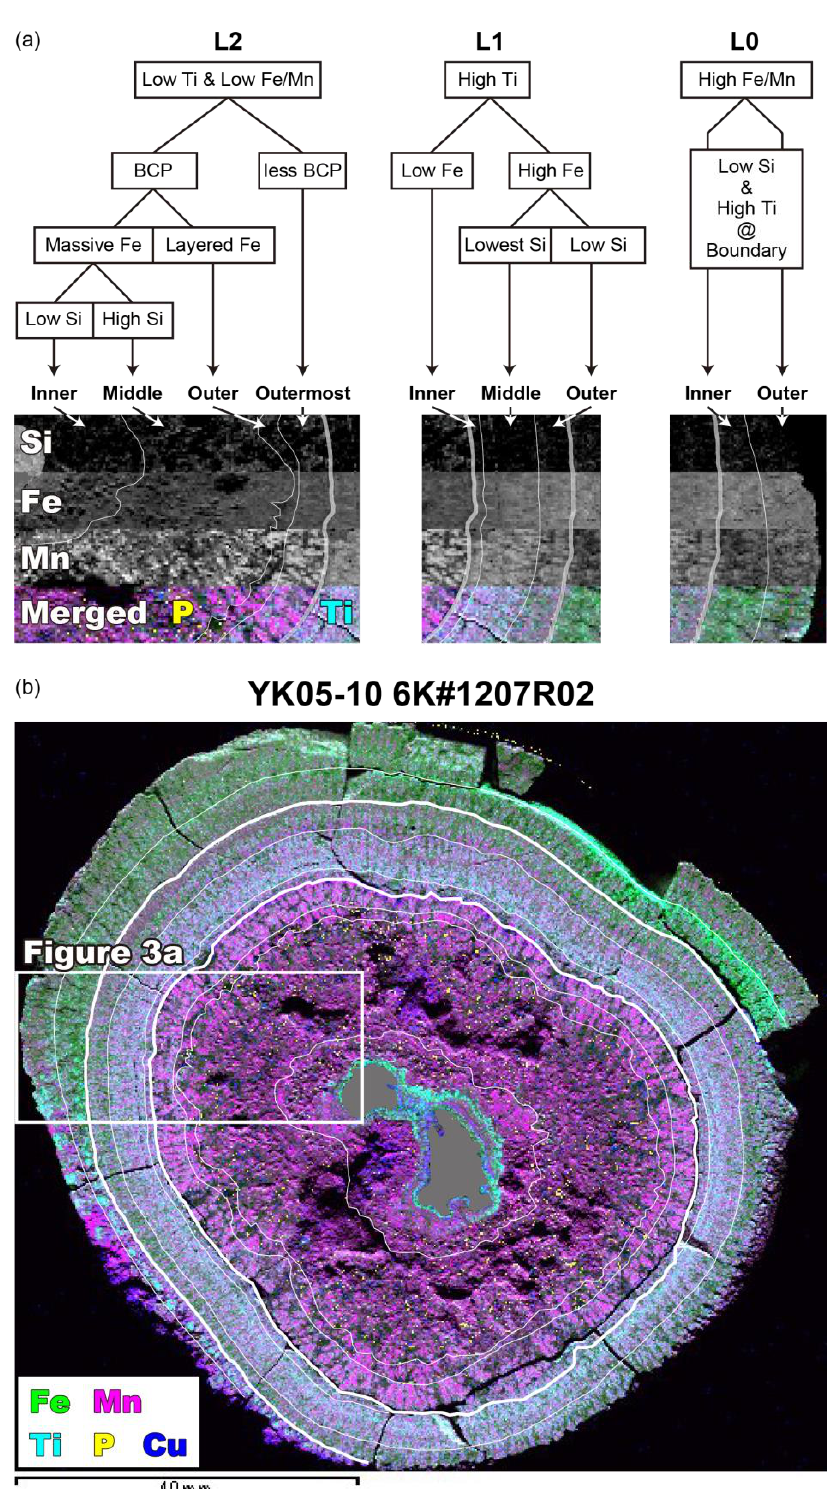
Figure 3. Definition criteria for chemostratigraphic layers determined by µ-XRF. ( a ) Flowchart to define the sublayers proposed by Machida et al. [13] (provided in Figure 7 of [13]); ( b ) An example of layer identification reported by Machida et al. [13] (modified from Figure 6 of [13]). The thick white lines indicate the boundaries of the layers L0, L1, and L2, and the thin white lines indicate the sublayer boundaries of each layer. The white box in (b) indicates the area shown in (a). The gray field indicates the nuclei of this sample.